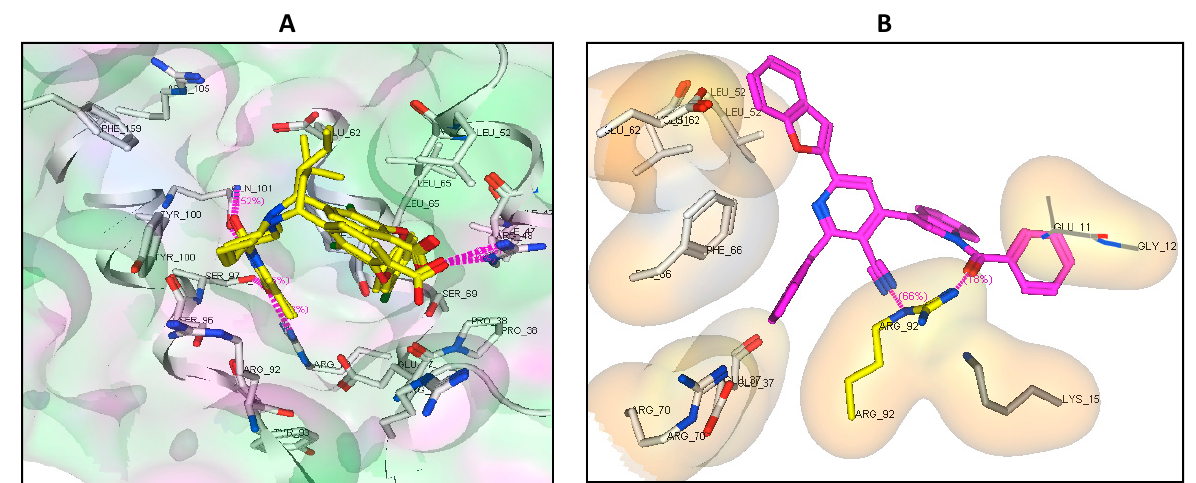
Figure 6. ( A ) The binding mode of the re-docked ligand within the binding pocket of TMPK (ID: 4QGG). The re-docked ligand shows superimposed on the same position as the native ligand (yellow, stick) with the same orientation. The two ligands show the same H-bonds profile with Gln101, Arg48, Arg70, Ser97 (white, stick); ( B ) The binding mode of compound 7d (pink, stick) within the binding pocket of TMPK (ID: 4QGG). Compound 7d shows π -cation interaction and two H-bound acceptors with the amine acid residue Arg92 (yellow, stick).